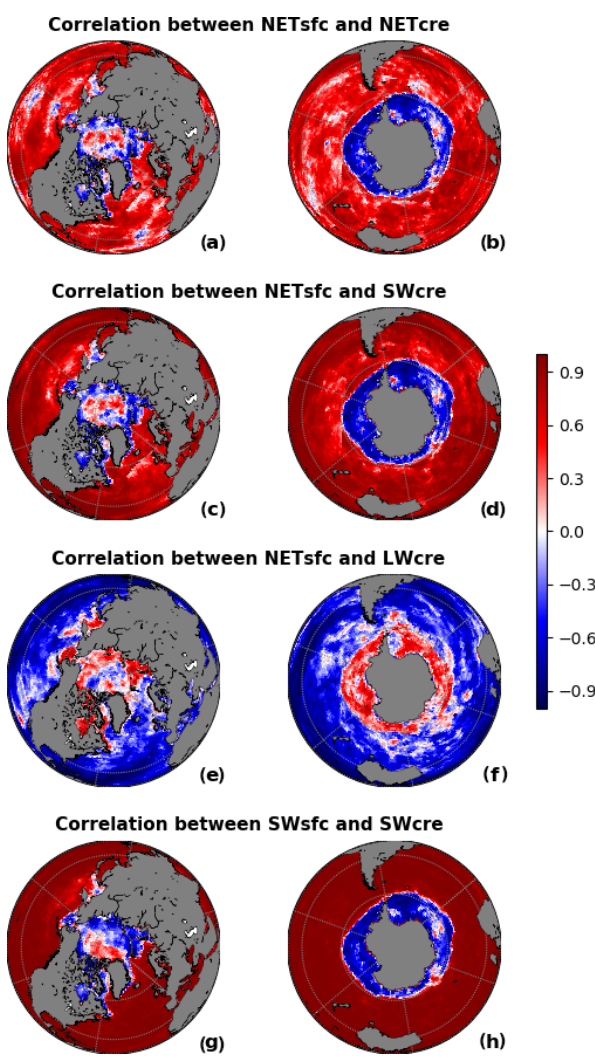
Figure 3. Correlation between TOA CRE and surface radia- tion budget terms over 2001–2016 from CERES measurements for the Northern Hemisphere (a, c, e, g) and Southern Hemi- sphere (b, d, f, h) polar sea. Positive correlations shown by the red colours indicate that years with less NET sfc coincide with years where NET cre has a stronger cooling effect and vice